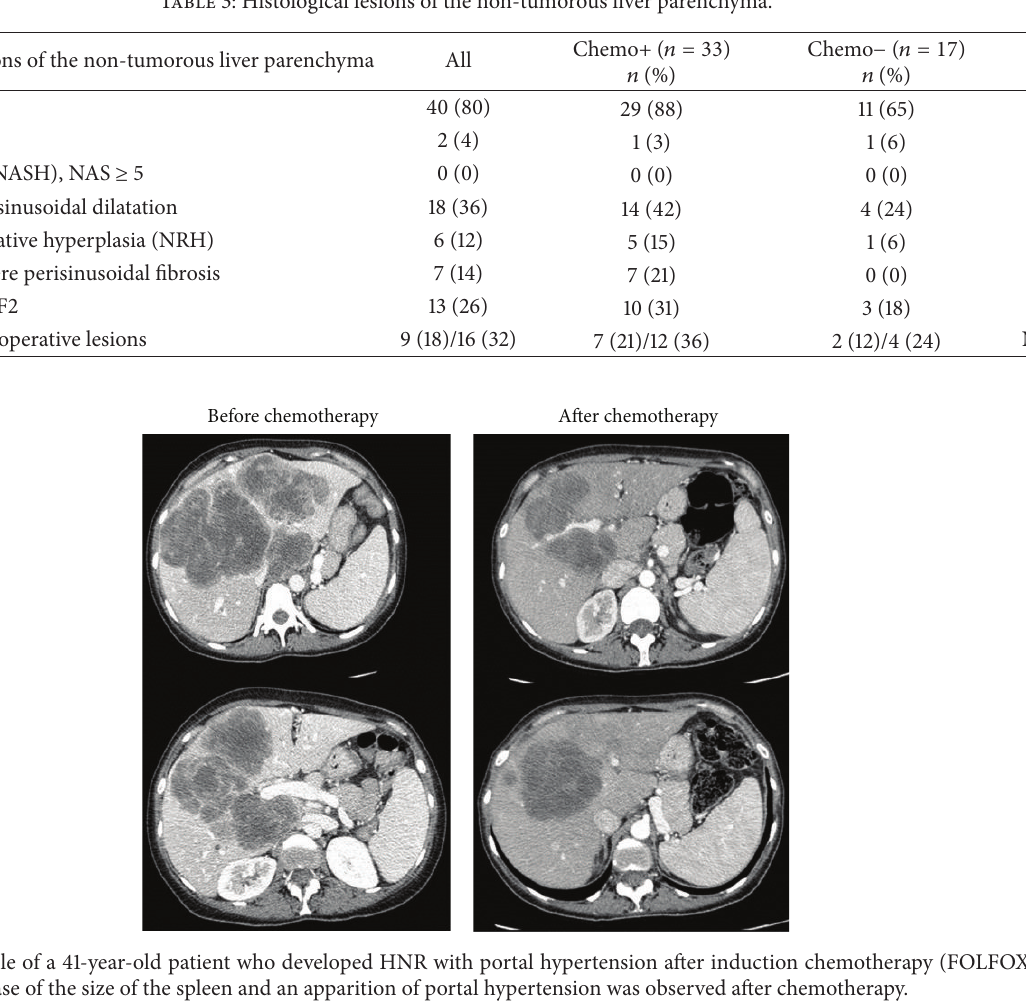
Table 3: Histological lesions of the non-tumorous liver parenchyma.